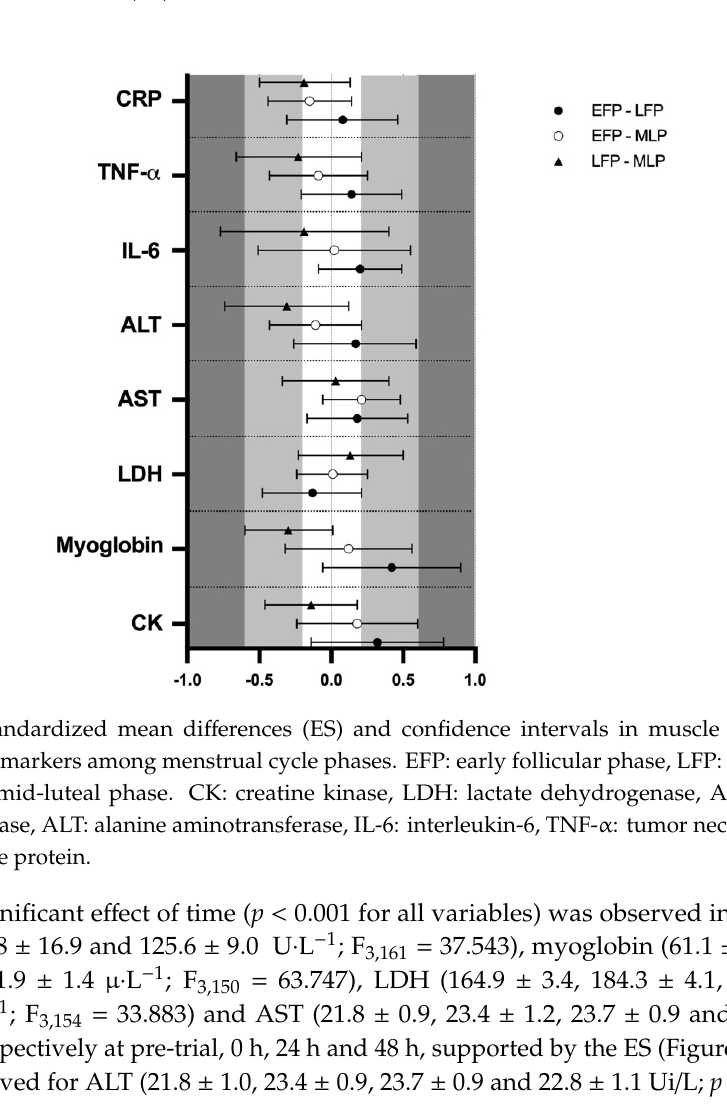
Figure 3. Standardized mean differences (ES) and confidence intervals in muscle damage and inflammation markers among time ‐ point measurements. (A)CK, myoglobin and LDH; (B)AST and